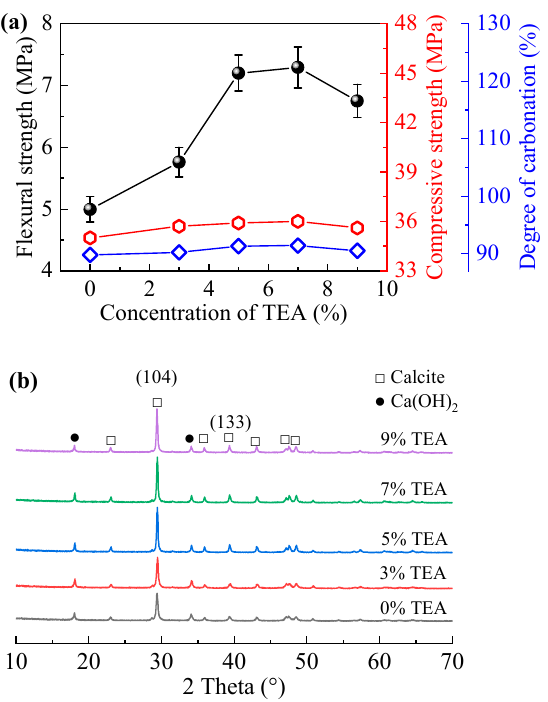
Figure 2. Flexural strength, compressive strength and DOC of CAM ( a ) and XRD patterns of CAM at different TEA concentrations ( b